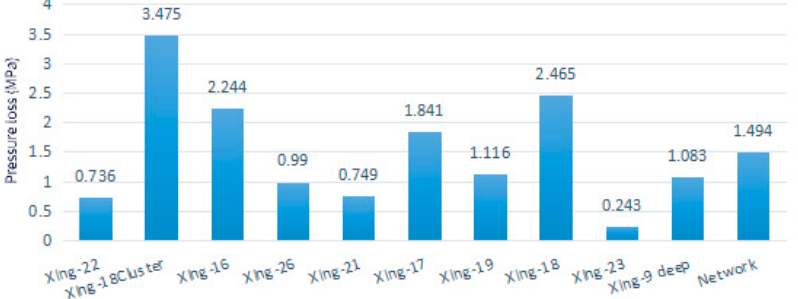
Figure 5. Maximum pressure loss from the station to end well.